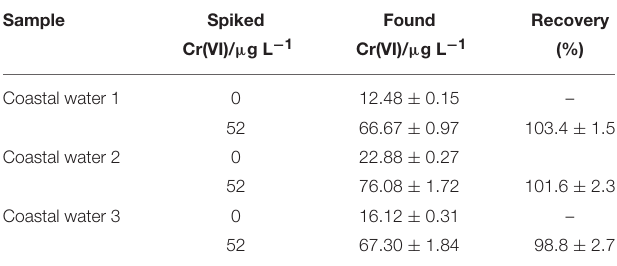
TABLE 1 | Determination of Cr(VI) in coastal water samples at AuNPs/Nano-TiC/GCE.